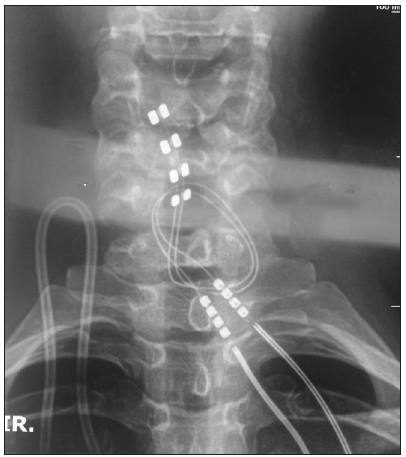
FIGURE 3. A patient affected by chronic phantom-limb pain was implanted with a cervical medullary electrode. The intraoperative radiography shows the positioning of the adequate electrode in the middle of vertebral column, inside the